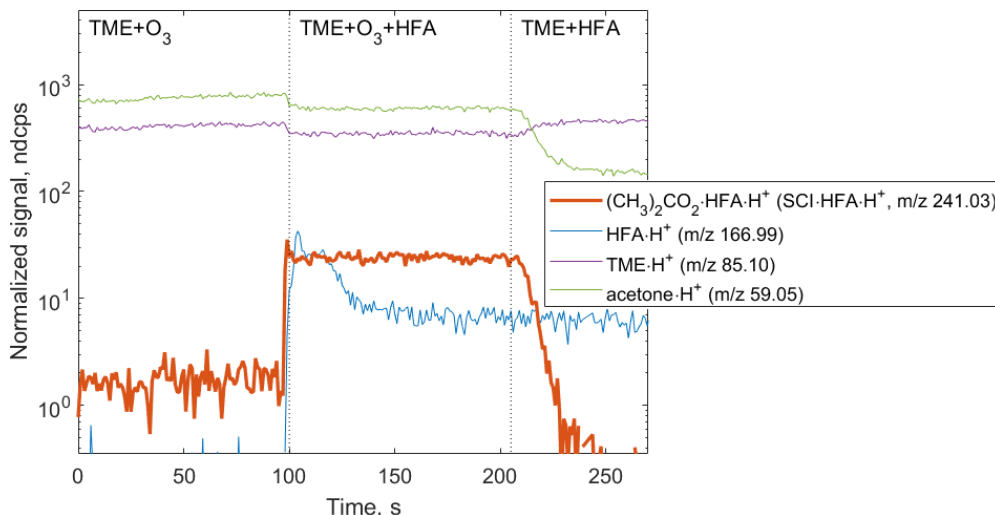
Figure 3. Ion tracers observed in a TME ozonolysis experiment as a function of the reactant conditions. Reactant concentrations are [TME] = 1 . 85 × 10 12 ; [ O 3 ] = 1 . 67 × 10 13 ; [HFA] = 6 . 09 × 10 15 moleculecm − 3 . ( CH 3 ) 2 COO when TME, HFA, and O 3 are present in the system.